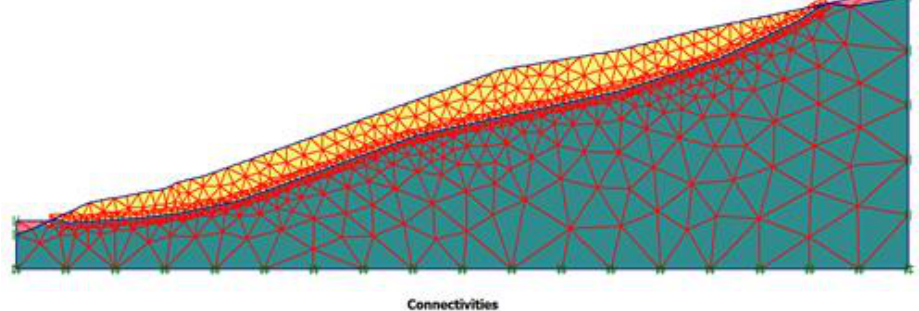
Fig. 10. Finite elements geometry and network with the interface element